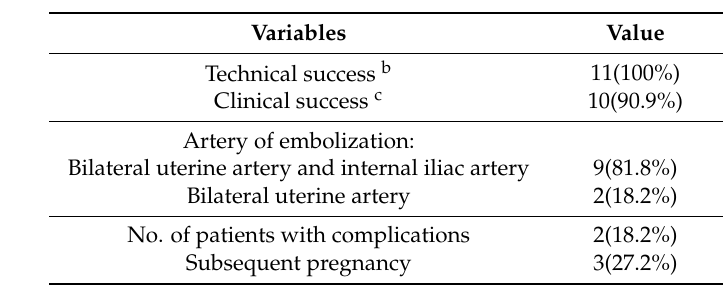
Table 4. Outcomes of TAE